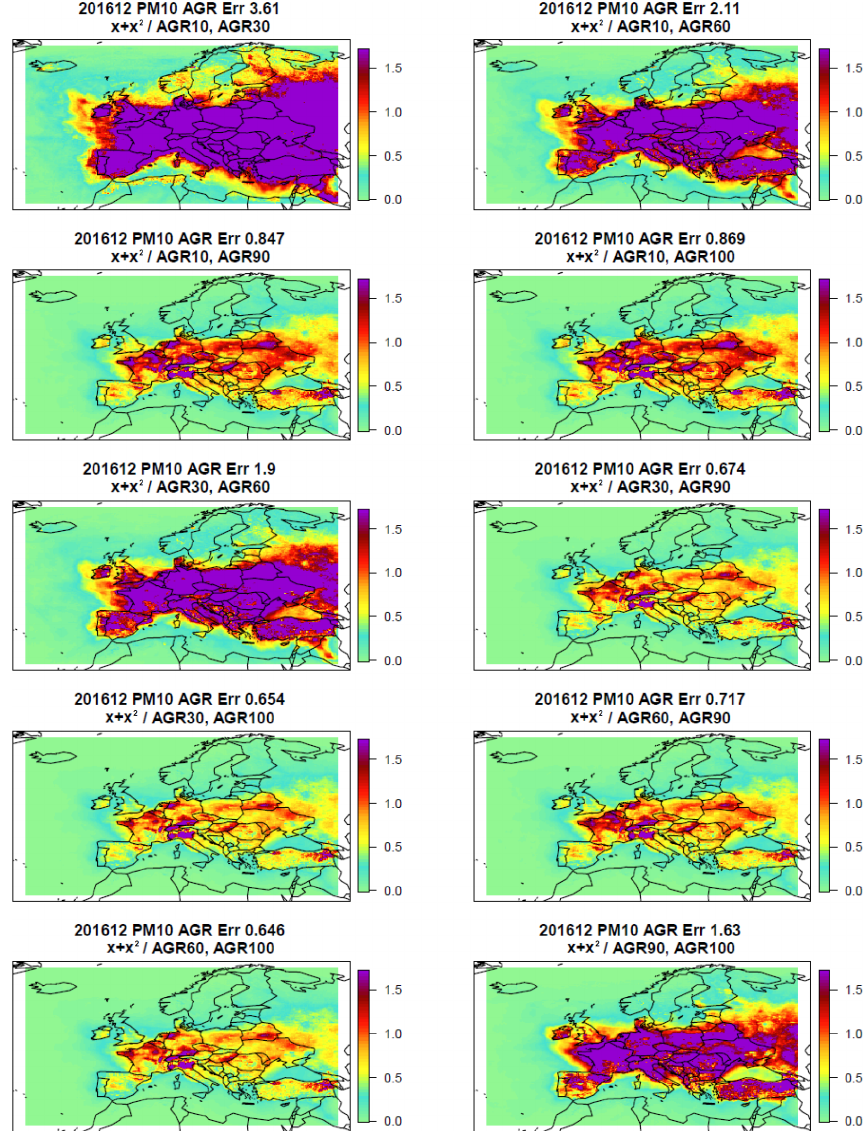
Figure 4. Relative error (%) averaged over the month of December 2016 for the quadratic univariate PM 10 models with respect to the agriculture activity sector. The sensitivity scenarios used to train the individual models are indicated in the title of each panel, as well as the average